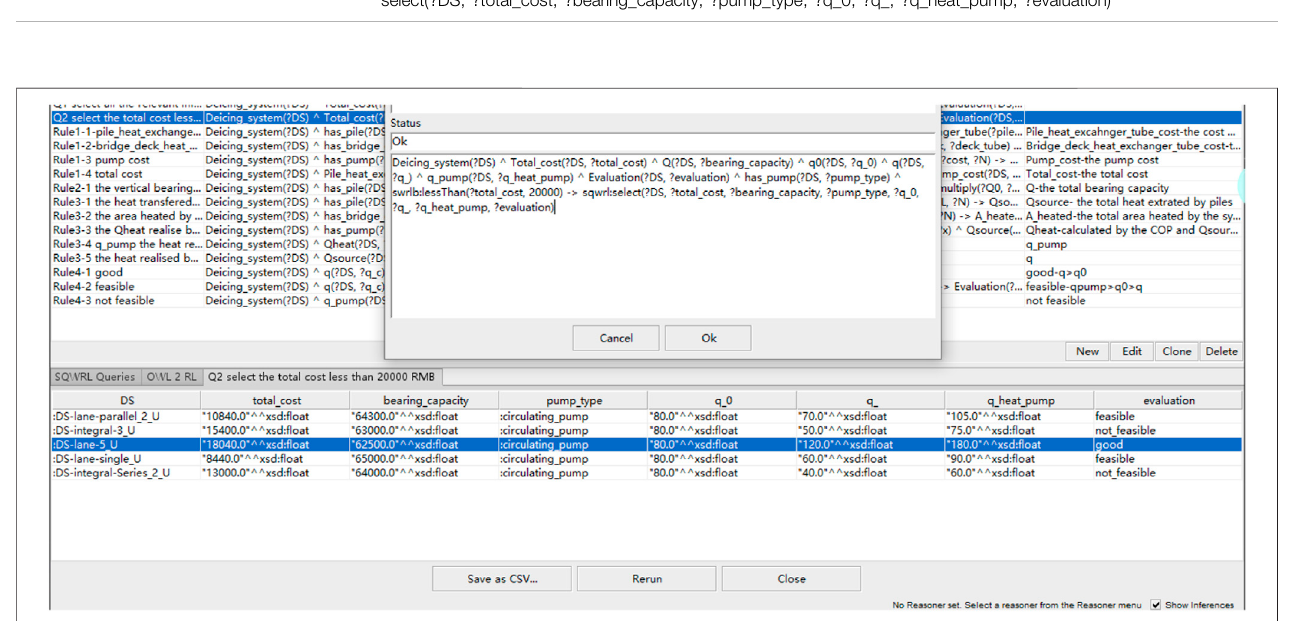
FIGURE 12 | Execution and results of querying Table 8